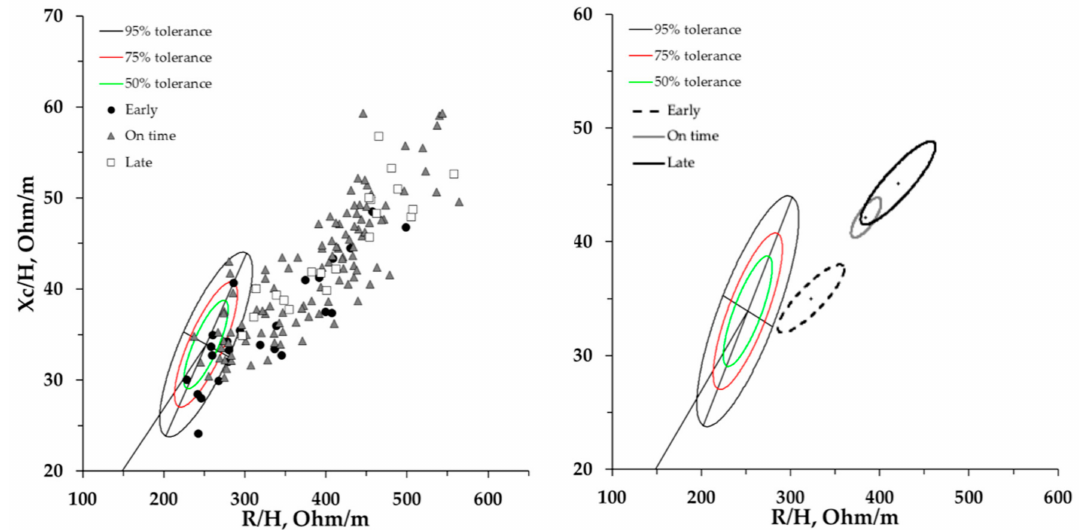
Figure 3. Mean and single impedance vectors plotted on the adult soccer players’ classic BIVA tolerance ellipses